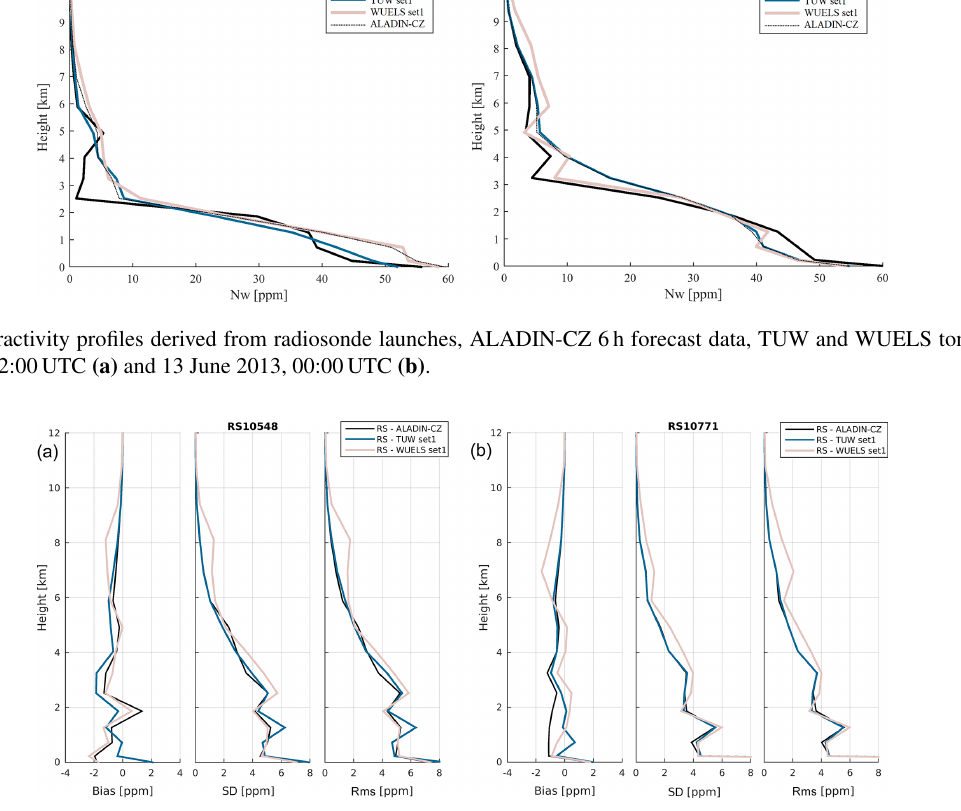
− 88, − 77 and − 3 are the general flags of the WRFDA sys- tem, whereas the numbers from − 31 to − 36 are the flags assigned by the GPSREF